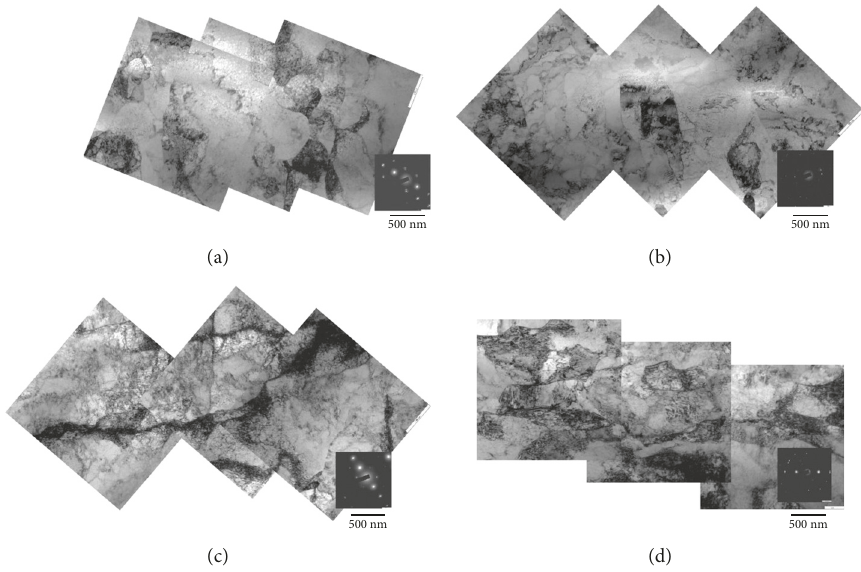
Figure 2: TEM micrographs of the SSE-processed sample: (a) two, (b) four, (c) eight, and (d) twelve